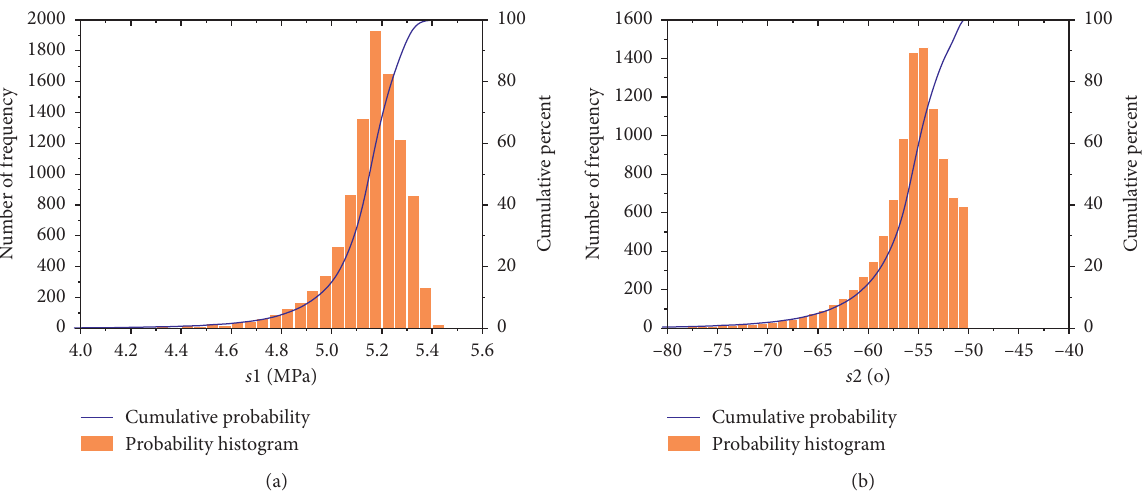
Figure 7: Results of global UA of shield machine intrinsic parameters within different model outputs in the baseline scenario: (a) average bubble chamber pressure per ring ( s 1); (b) deviation angle per ring ( s